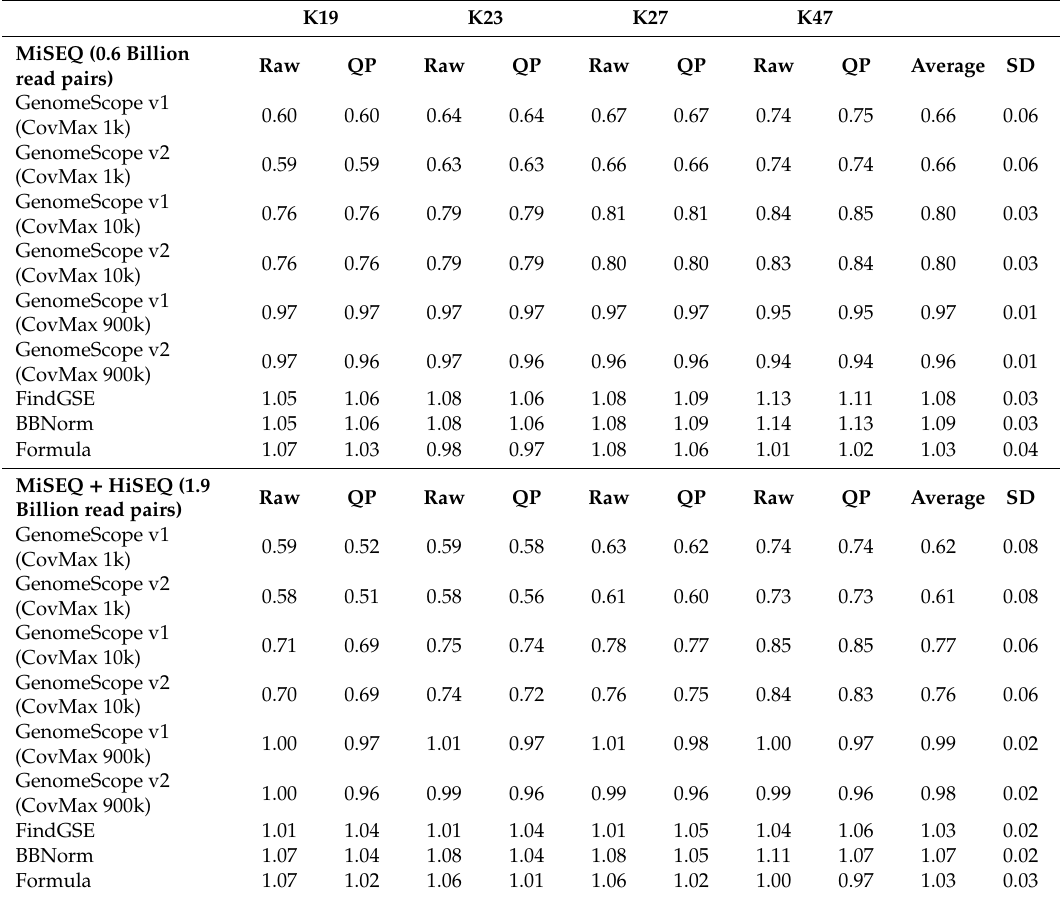
Table 2. Genome size estimates for one commercial rooibos genotype (in Gbp) using raw and quality processed Illumina sequencing data. K19 K23 K27 K47 MiSEQ (0.6 Billion read pairs)